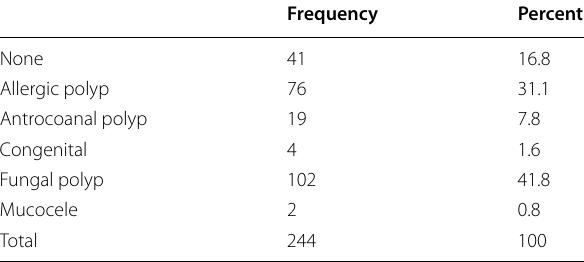
Table 2 Clinical diagnosis after histopathology: non-neoplastic masses among patients with sinonasal masses in Khartoum